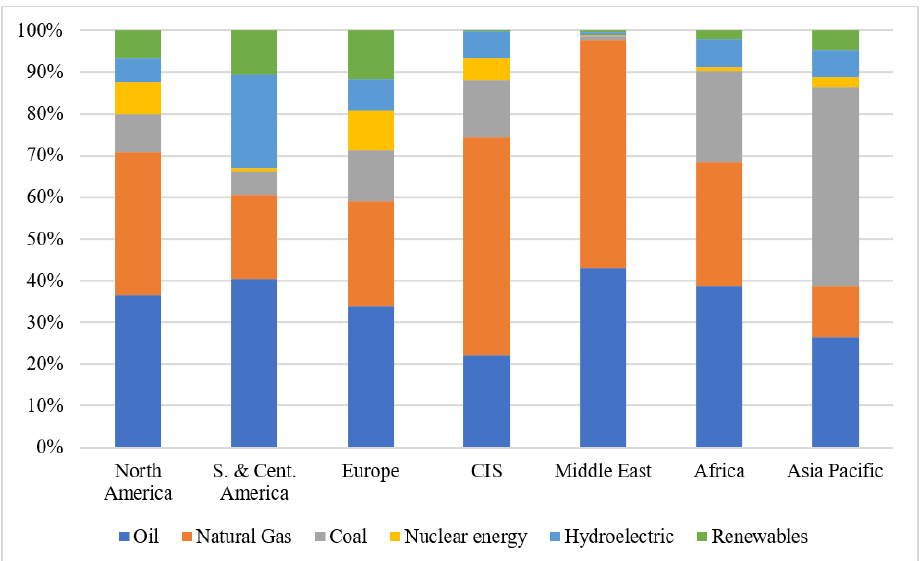
Figure 2. Energy and fuel mix by macroregions in 2020. Source: compiled by author based on the BP’s Statistical Review of World Energy.